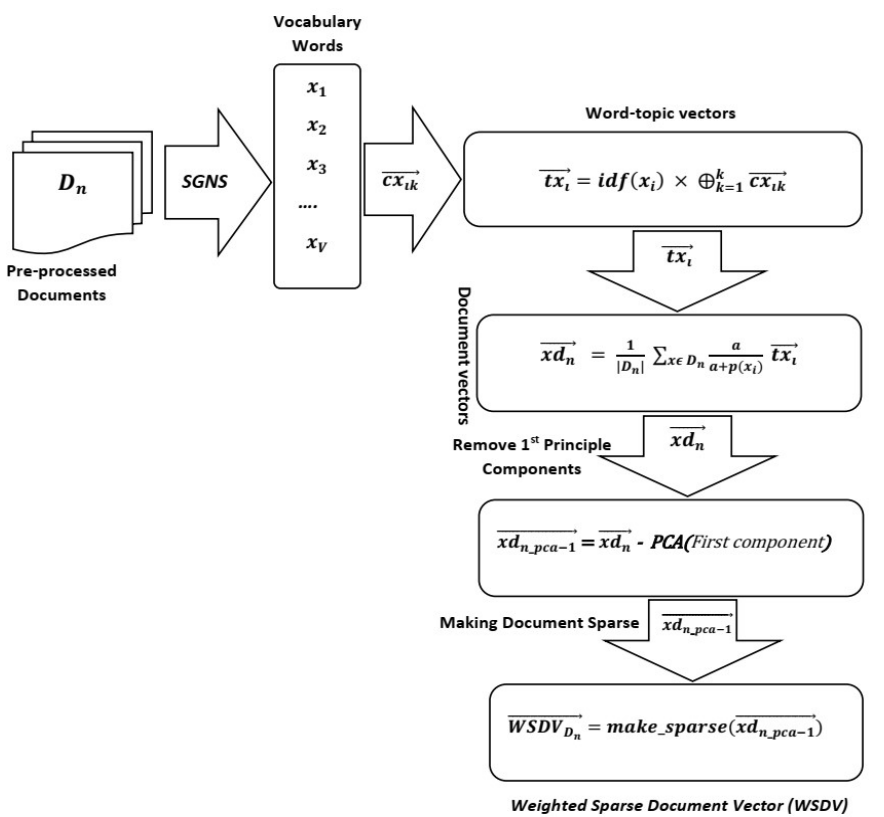
Figure 2. Weighted Sparse Document Vector formation in to d × k dimensional embedding